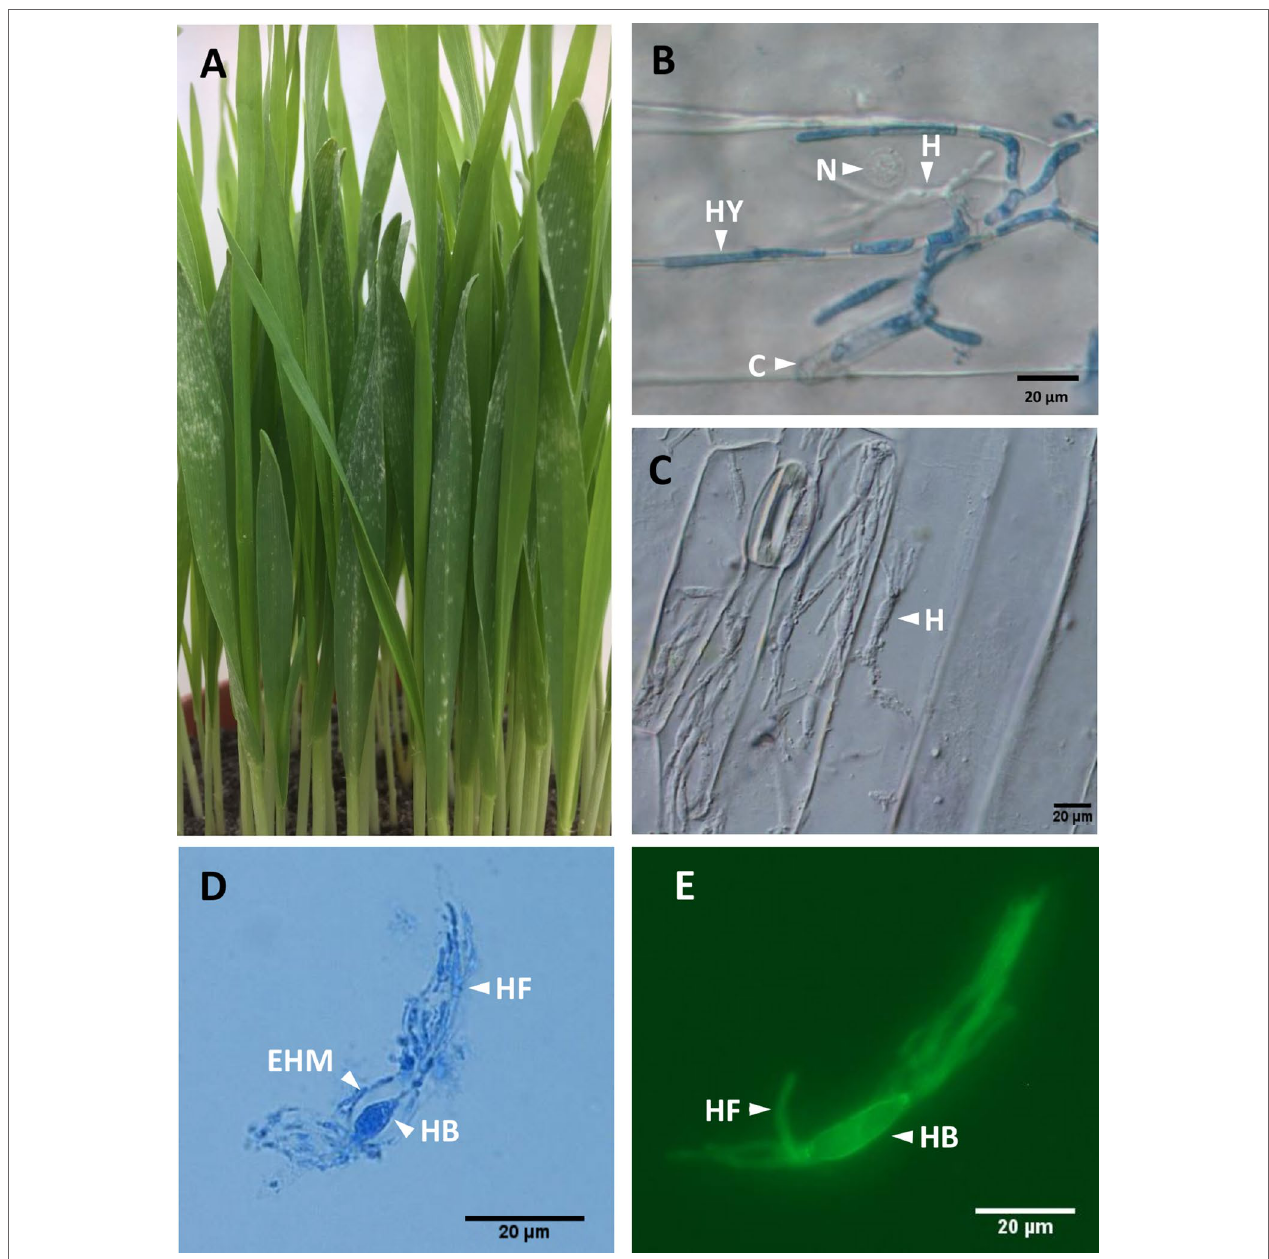
FIGURE 1 | Blumeria graminis f. sp. hordei ( Bgh ) infection structures. (A) , Barley powdery mildew infected plants at 5–6 dpi, showing emergence of white pustules as disease symptoms. At this stage, the leaves are green and turgescent. (B) , Bgh infection structures at 2 dpi showing conidia (C) , hyphae (HY), haustorium (H), and barley nucleus (N). In leaves stained with lactophenol blue, (C) , Barley epidermal strips from heavily infected plants, after removal of Bgh hyphae. Several haustoria (H) within a single barley epidermal cell can be observed. DIC light microscopy. (D) , Bgh haustorium isolated from infected barley epidermis, stained with lactophenol blue, showing the haustorial body (HB) and haustorial fingers (HF) surrounded by an extrahaustorial material (EHM). DIC light microscopy. (E) , Bgh haustorium isolated from infected barley epidermis, labelled with the fluorescent wheat germ agglutinin WGA-AF 488 showing haustorial body (HB) and haustorial fingers (HF), visualized using DAPI suitable conditions. DIC, differential interference